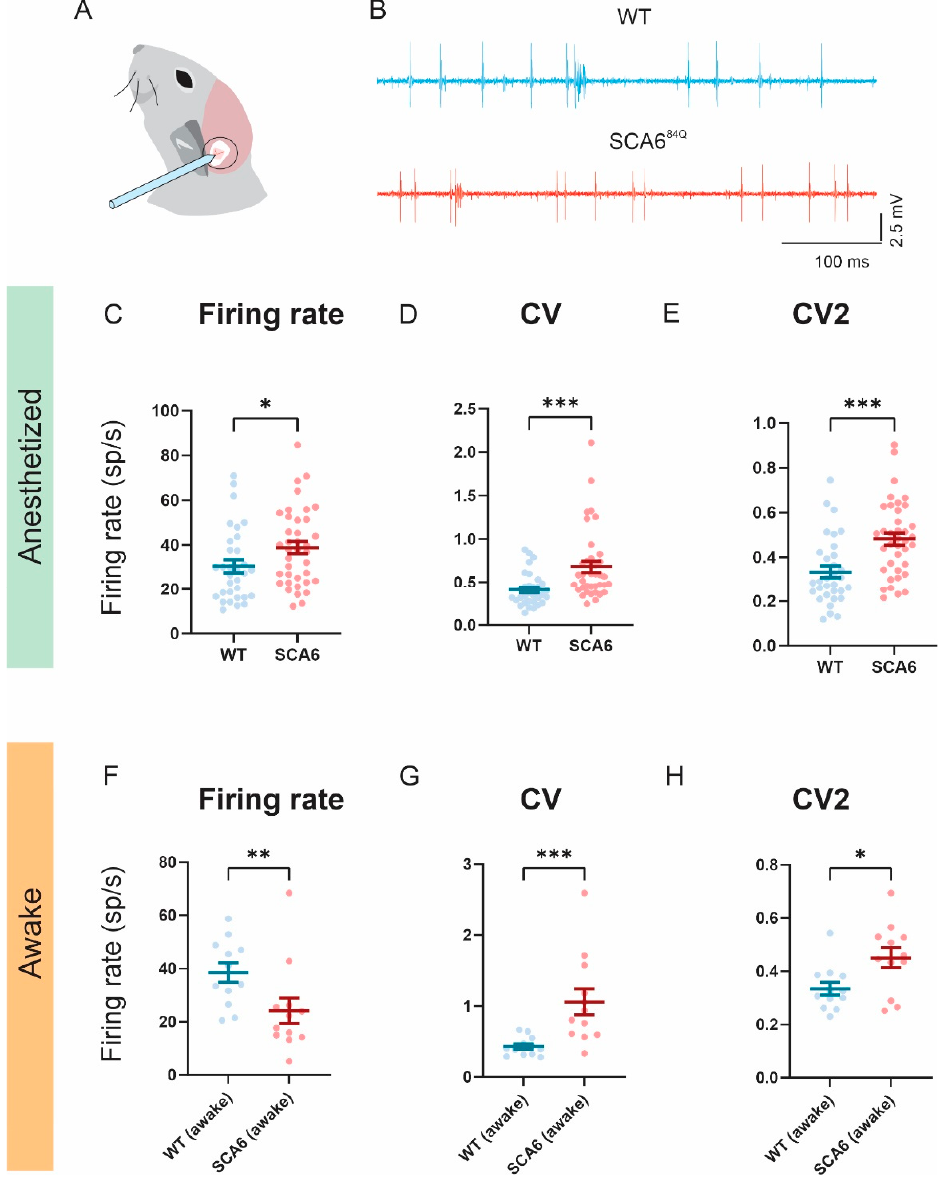
Figure 4. Firing precision is altered in SCA6 84Q mice. ( A ) Schematic of the experimental setup. ( B ) Sample recordings from anesthetized wild-type (WT, blue) and SCA6 84Q mice (red). ( C – E ) Comparison of firing rate, CV, and CV2 of simple spikes in the anesthetized state. Firing rate ( C ) is increased in SCA6 84Q mice (WT: frequency = 30.49 ± 2.89 sp/s; SCA6 84Q mice: frequency 38.83 ± 2.81 sp/s). CV ( D ) is increased in SCA6 84Q mice (WT:CV = 0.41 ± 0.03; SCA6 84Q mice: CV 0.68 ± 0.07). CV2 ( E ) is increased in SCA6 84Q mice (WT:CV2 = 0.33 ± 0.03; SCA6 84Q mice:CV2 0.48 ± 0.03). n = 32 cells for WT; n = 38 cells for SCA6 84Q mice ( F – H ) Comparison of firing rate, CV, and CV2 of simple spikes in the awake state. Firing rate ( F ) is decreased in SCA6 84Q mice (WT: frequency = 38.49 ± 3.58 sp/s; SCA6 84Q mice: frequency 24.22 ± 4.84 sp/s). CV ( G ) is increased in SCA6 84Q mice (WT:CV = 0.43 ±